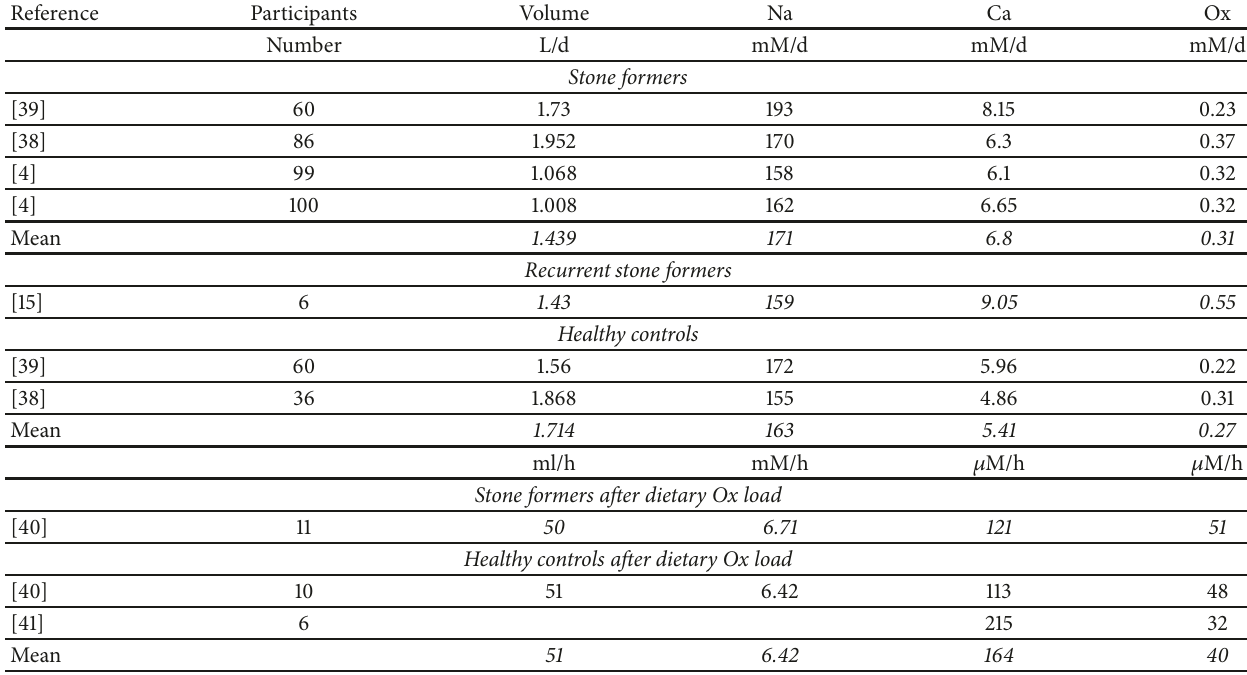
Table 1: Afflux of important components for stone formation in urine of stone formers and healthy